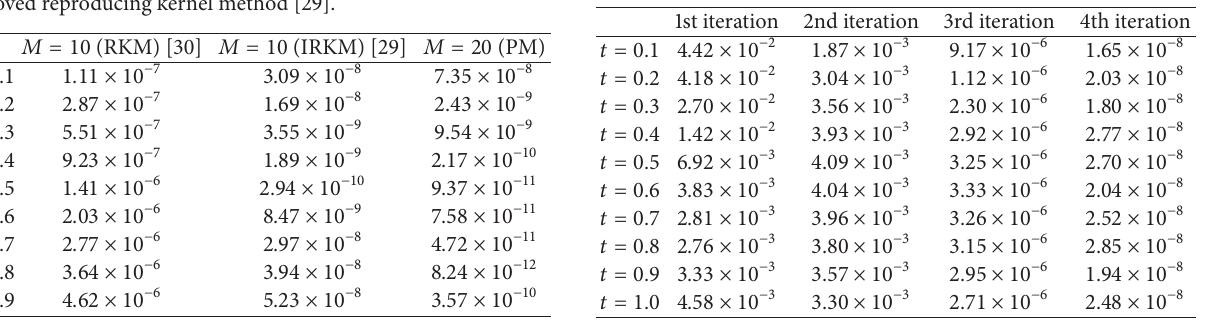
Table 3: Absolute difference of exact and approximate solution of Example 3 at different stages of the iteration.